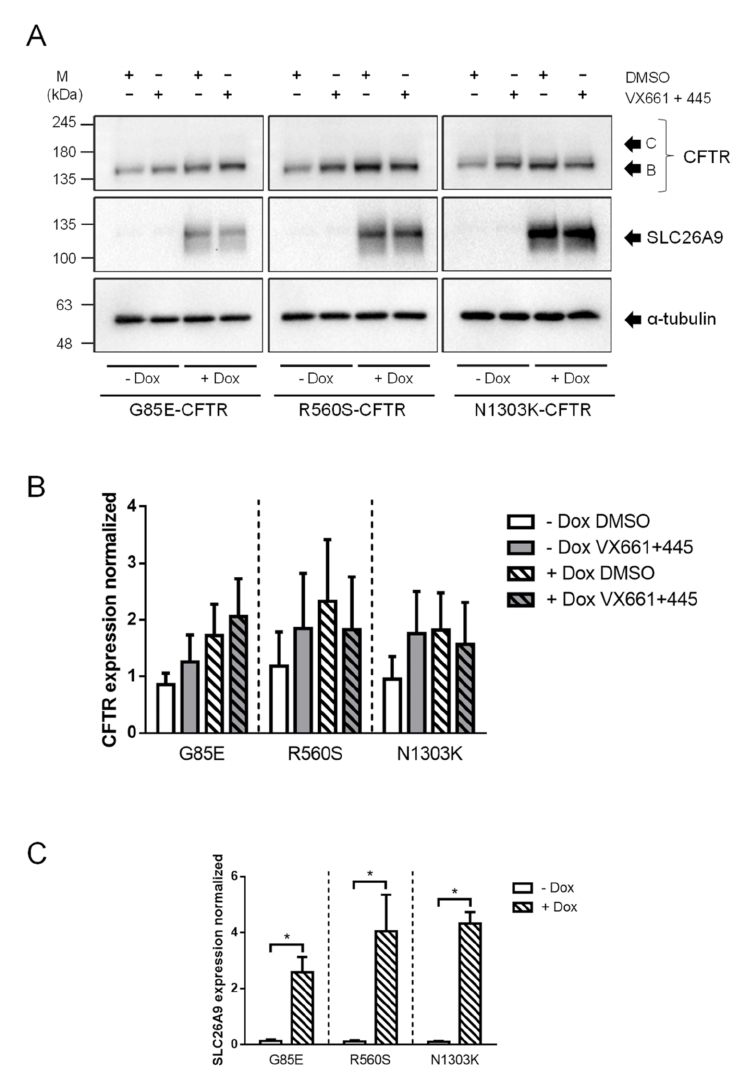
Figure 6. Overexpression of SLC26A9 does not alter the PM expression of other class II CFTR mutants. ( A ) Western Blot showing CFTR and SLC26A9 expression in CFBE cells transduced with SLC26A9 and stably expressing one of the following class II CFTR mutants: G85E, R560S, or N1303K. SLC26A9 expression is detectable after Doxycycline induction (+Dox). α -tubulin was used as a loading control. ( B ) Quantification of CFTR protein expression detected by WB in ( A ). ( C ) Quantification of SLC26A9 overexpression after Dox induction, as shown in ( A ). Data are normalized to loading control and showed as mean ± SEM ( n = 3). (*) indicates significant difference between cells in the absence or presence of Dox (unpaired t -test, p ≤